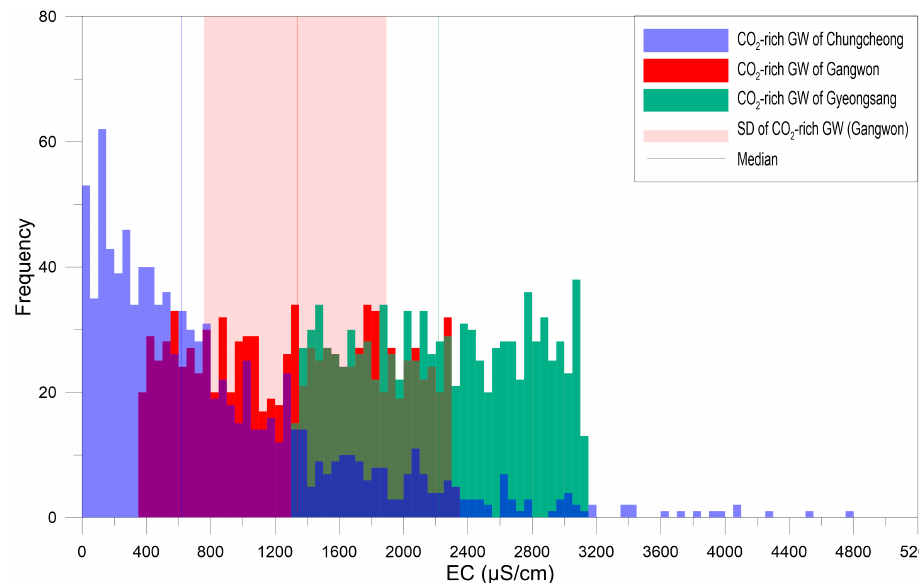
Figure 9. Comparison of EC PDFs of CO 2 -rich groundwater in Gangwon (red), Chungcheong (blue), and Gyeongsang (green) Provinces.